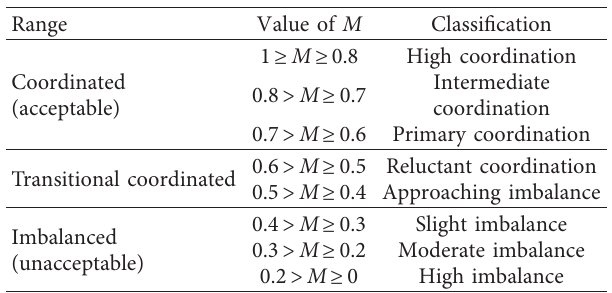
Table 3: Classification of